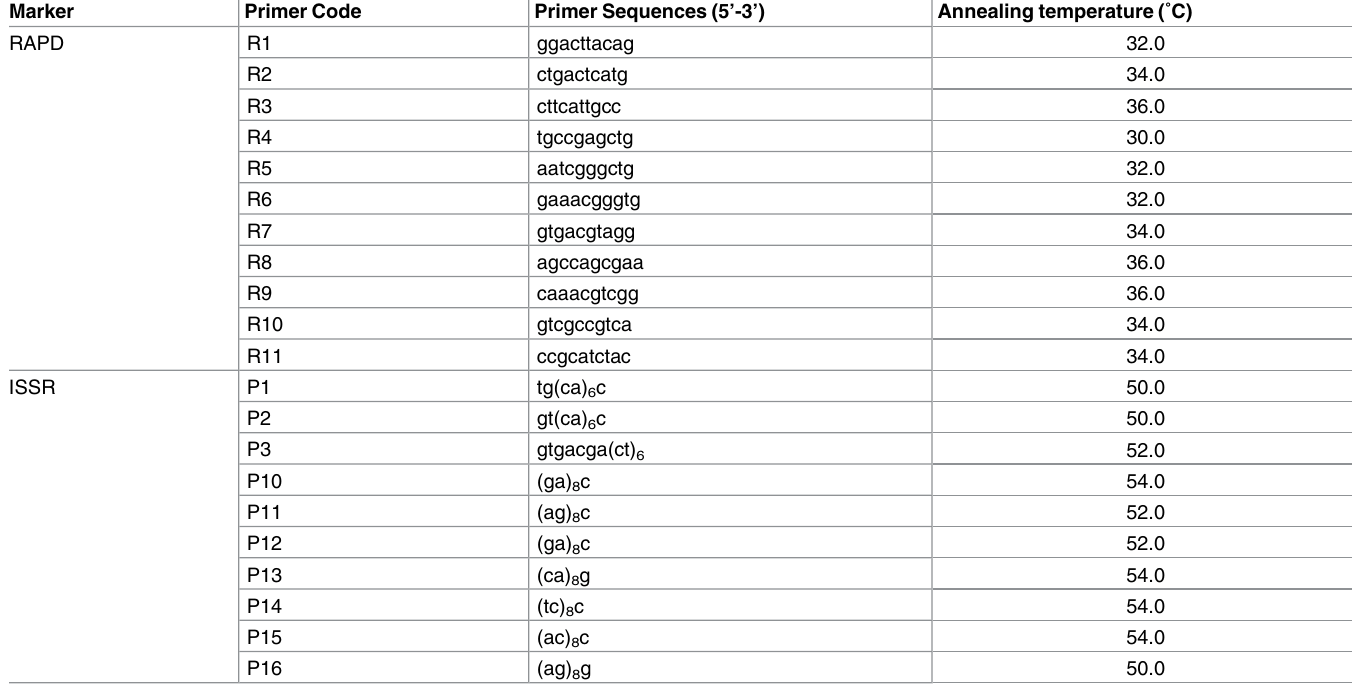
Table 1. RAPD and ISSR primers and corresponding annealing temperatures used.